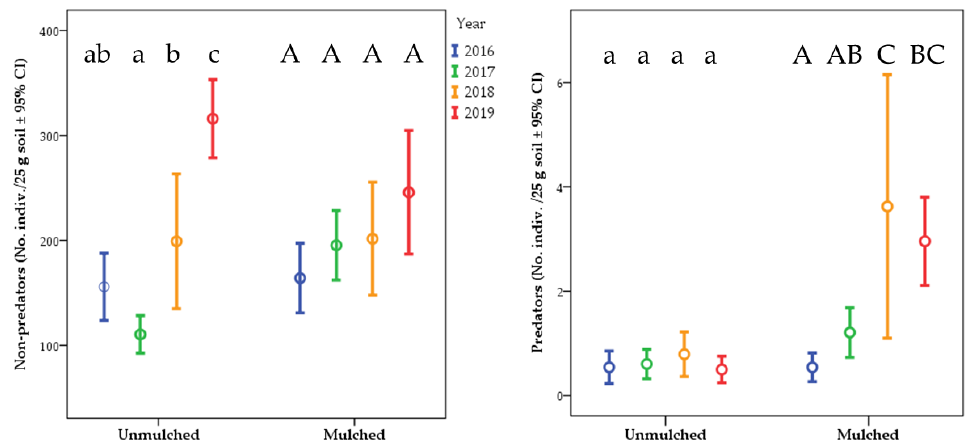
Figure 2. Numbers of predatory and non-predatory nematodes in mulched vs. unmulched open- field tomato plots in four consecutive experimental years. Gödöllő, Hungary. (One-way ANOVA, LSD (Least Significant Difference) post hoc test. Different letters indicate significant difference at p<0.05 level. Small letters refer to the differences within unmulched, uppercase letters refer to the differences within mulched treatment. CI 95% means 95% of Confidence Interval).